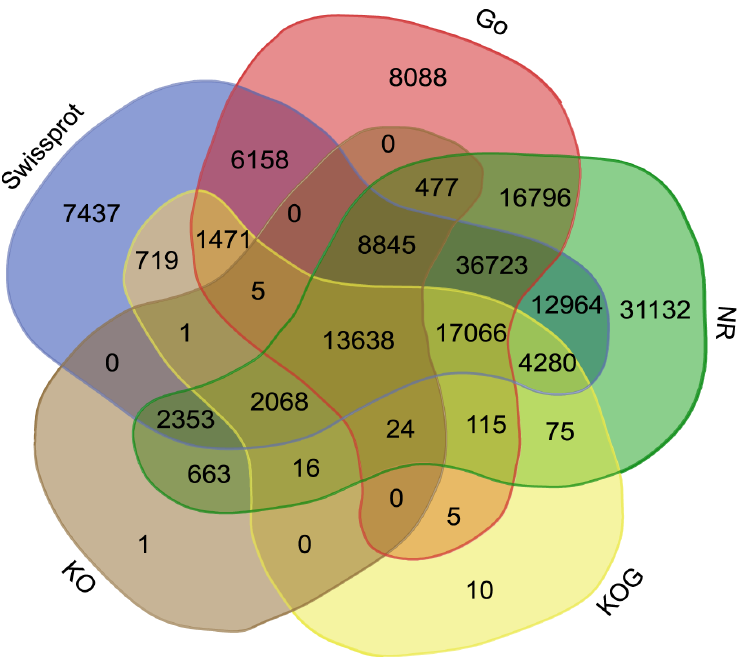
Fig 2. Venn diagram of unigene annotations from the Nr, Swiss-Prot, KOG (EuKaryotic Orthologous Groups), GO (Gene Ontology), and KO (KEGG ortholog) databases.